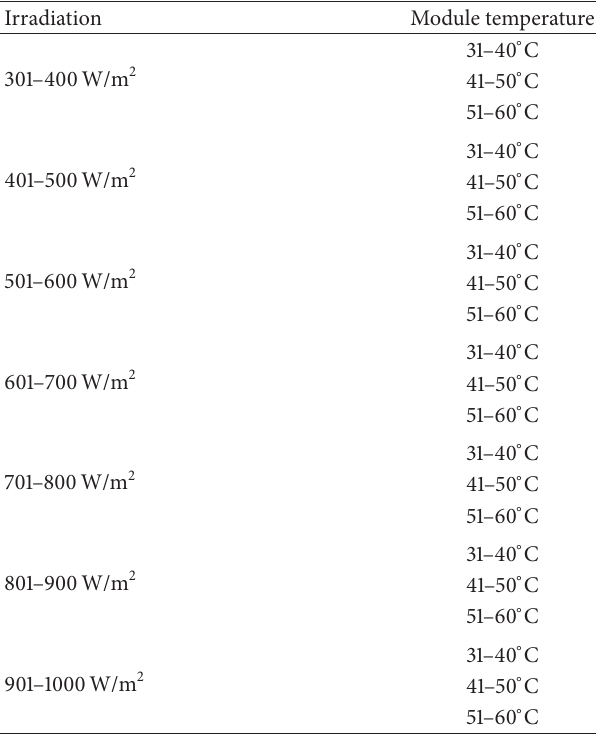
Table 3: The 21 intervals differentiated by temperature and irradia-